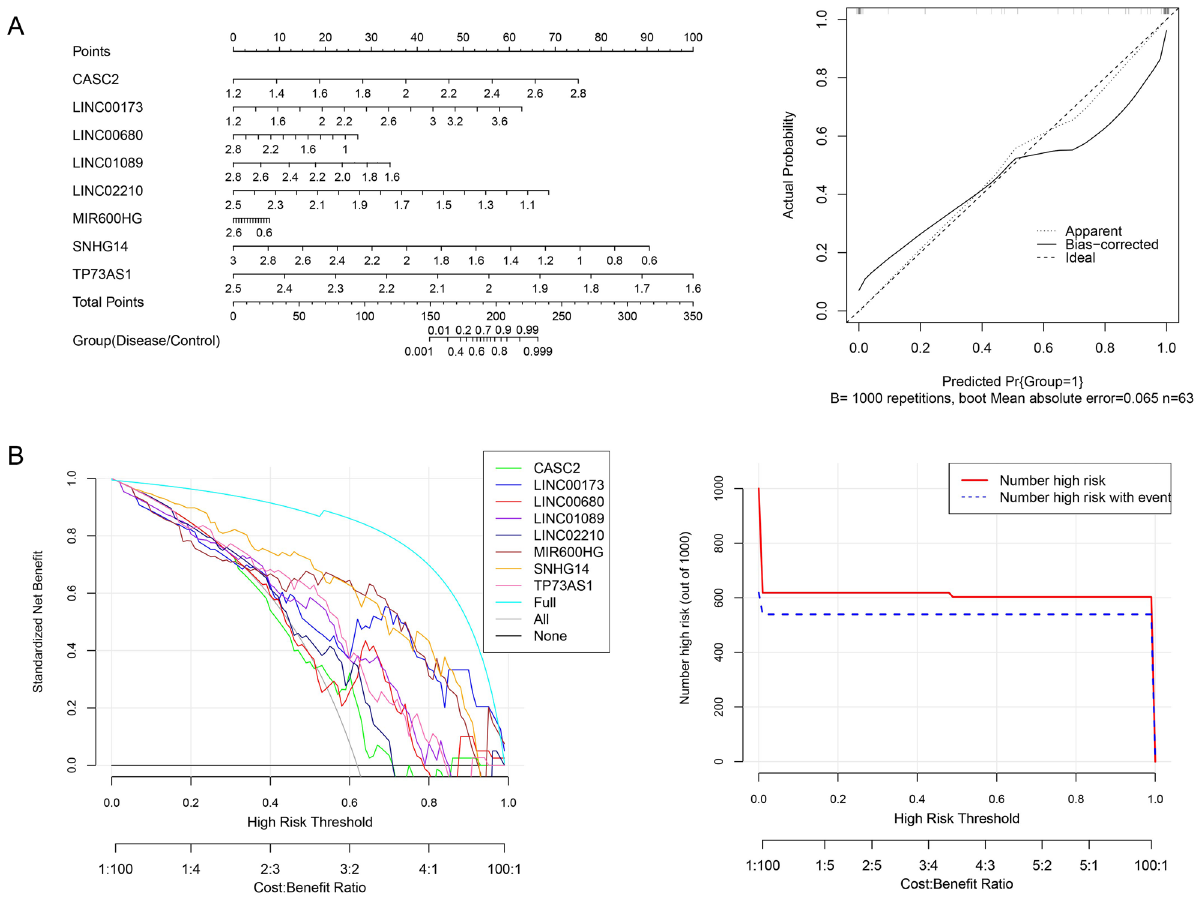
Figure 4. The diagnostic nomogram applied to the training set GSE16561 and the corresponding calibration curve ( A ) and the decision curve analysis ( B